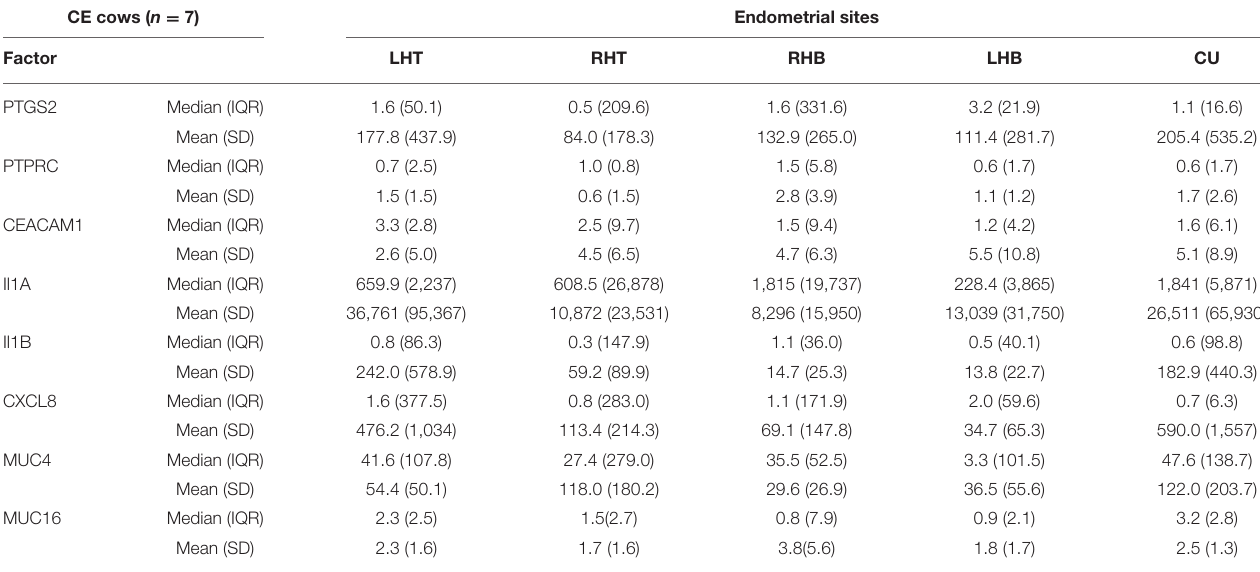
TABLE 1 | Median, interquartile range (IQR), mean, and standard deviation (SD) of normalized mRNA expression for different pro-inflammatory factors and mucins in the endometrium at the corpus uteri (CU), the base of the left horn (LHB), the tip of the left horn (LHT), the base of the right horn (RHB) and the tip of the right horn (RHT) collected from seven cows with clinical endometritis (CE) on day 28 to 34 postpartum. CE cows ( n =